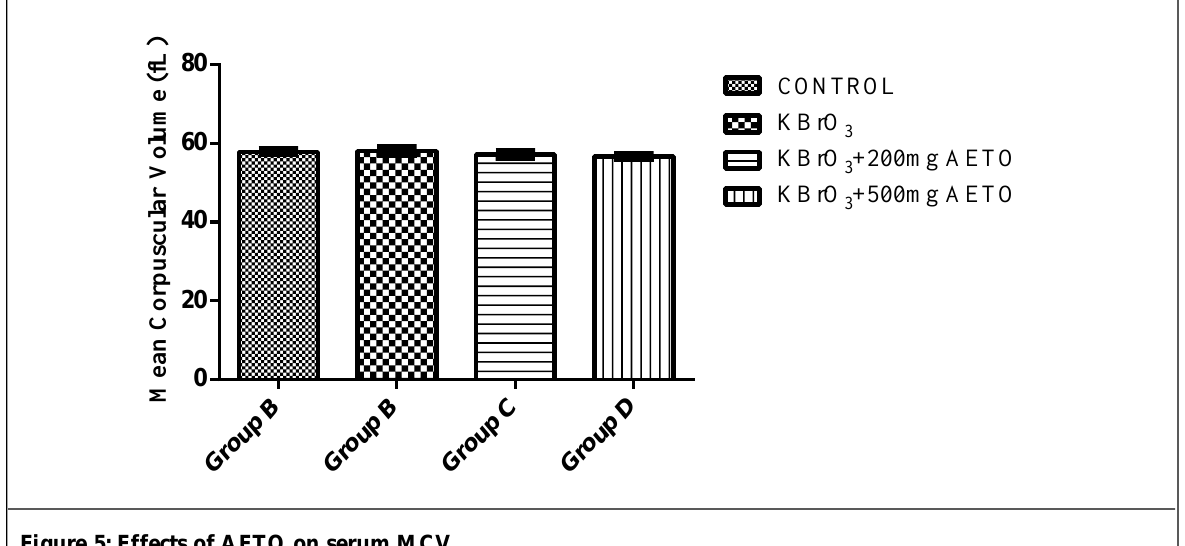
Figure 5: Effects of AETO on serum MCV Note: Value of p < 0.05 was considered significant. The values with superscript  = significantly different from group A,  = significantly different from group B. MCV – Mean Corpuscular Volume.